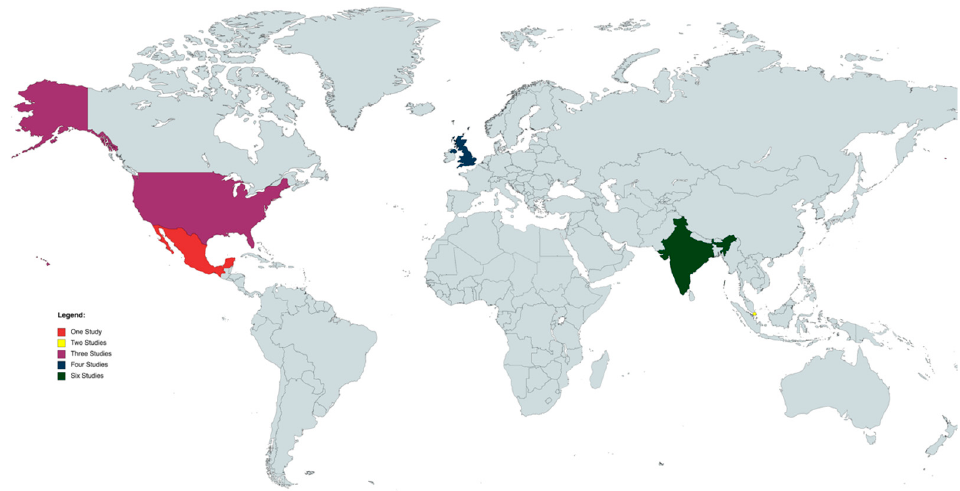
Figure 2. World map of studies included. Map generated through MapChart (MapChart, 2021).